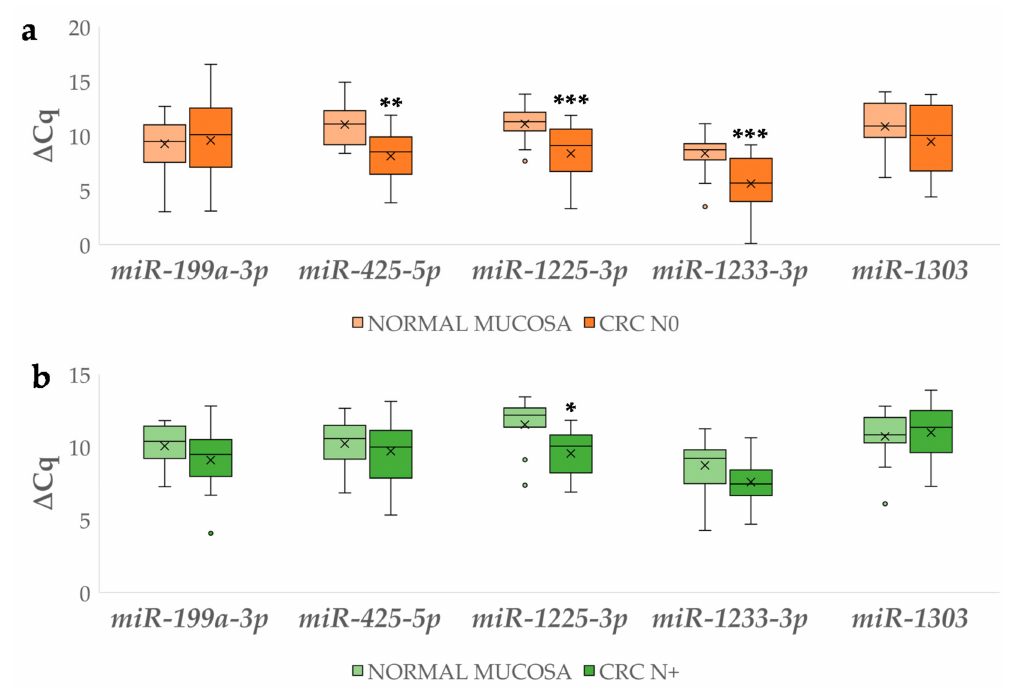
Figure 6. Expression ( ∆ Cq) of the investigated miRNAs in carcinoma without ( a ) and with lymph node metastases ( b ) in comparison to corresponding normal mucosa. Legend: CRC N0, colorectal carcinoma without lymph node metastases; CRC N+, colorectal carcinoma with lymph node metastases; x, mean; ◦ , outlier; * p ≤ 0.05, ** p ≤ 0.01; *** p ≤